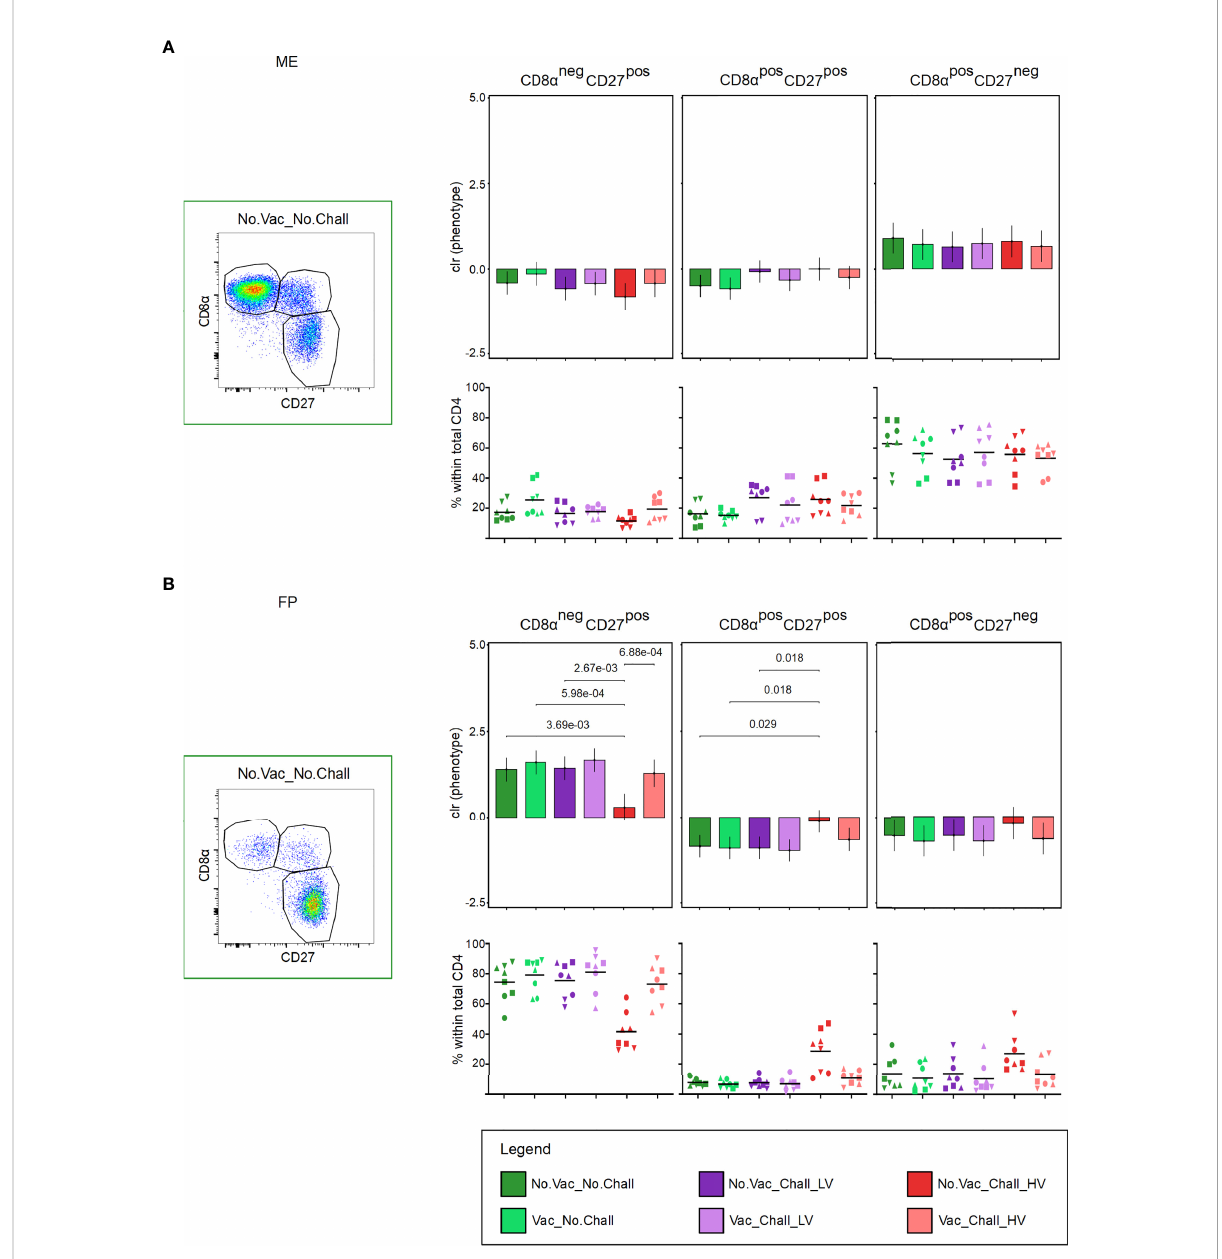
FIGURE 6 CD8 a and CD27 expression of CD4 T cells at the maternal-fetal interface. (A, B) Total CD4 T cells were investigated for their expression of CD8 a and CD27. CD8 a neg CD27 pos (representing naive), CD8 a pos CD27 pos (representing early effectors or central memory, Tcm), and CD8 a pos CD27 neg (representing late effectors of effector memory, Tem) cells were identi fi ed. Representative pseudocolor plots for the (A) maternal endometrium (ME) and the (B) fetal placenta (FP) from a No.Vac_No.Chall fetus are shown. Univariate compositional data analysis was performed for the three CD8 a / CD27-de fi ned CD4 T cell subsets. Results are represented in the bar charts (top panel; (A) ME; (B) FP). The y-axes depict the estimated marginal means (emmeans) of the centered log ratios (clr) for the speci fi ed CD4 T cell subset. Only signi fi cant p-values (p < 0.1), corrected for multiple testing using a false discovery rate approach, across all pairwise comparisons of contrasts for all (nine) compositional cell subsets and both tissues, are shown above the brackets. The whiskers depict the 95% con fi dence intervals of the clr-transformed data. The graphs in the bottom panel (A) ME; (B) FP) show the frequencies of the CD8 a /CD27-de fi ned CD4 T cell subsets within total CD4 T cells. For all graphs, results for each individual fetus are shown and different symbols indicate fetuses from different gilts. The black bars in the graphs display the mean within the respective treatment group. For all bar plots and graphs shown, the depicted treatment groups are: No.Vac_No.Chall (dark green, non-vaccinated and non-infected), Vac_No.Chall (light green, vaccinated and non-infected), No.Vac_Chall_LV (dark purple, non-vaccinated and infected low virulent strain), Vac_Chall_LV (light purple, vaccinated and infected low virulent strain), No.Vac_Chall_HV (dark red, non-vaccinated and infected high virulent strain), and Vac_Chall_HV (light red, vaccinated and infected high virulent